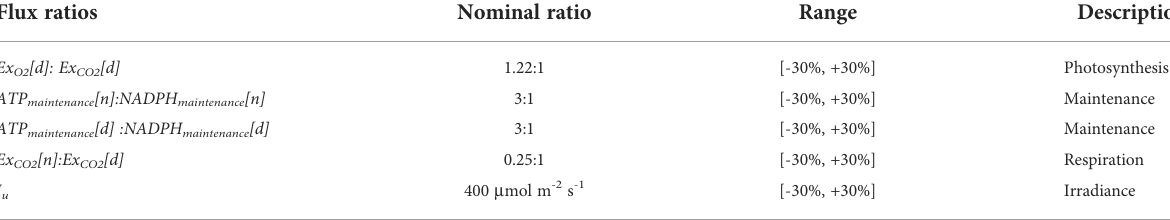
The percentage is applied to the nominal ratio (i.e., for the photosynthesis rate ratio, the range explored is from 0.8:1 to 1.59:1). The whole range is split into six